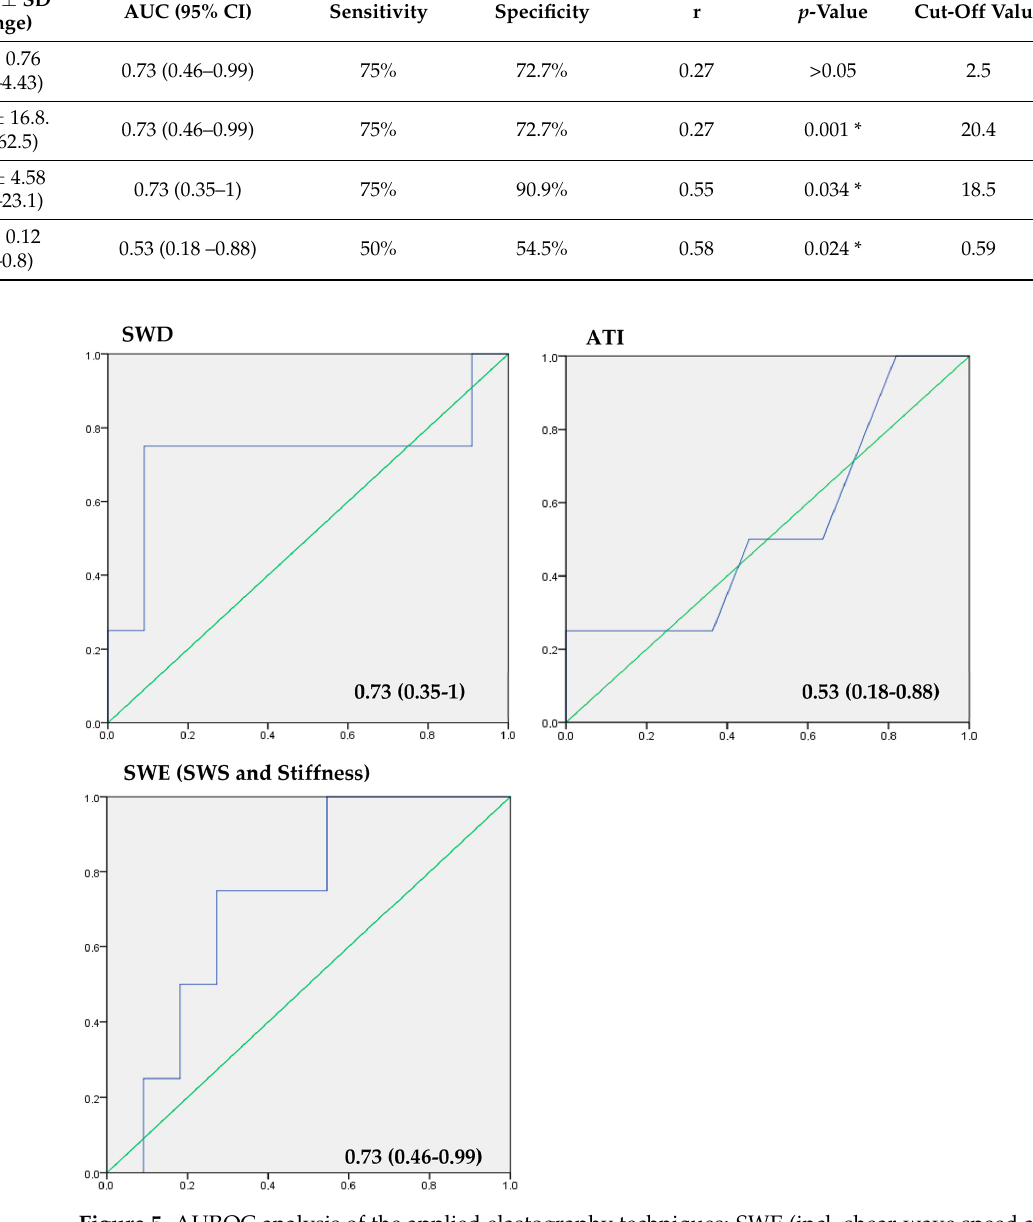
Figure 5. AUROC analysis of the applied elastography techniques: SWE (incl. shear-wave speed and stiffness measurements), SWD and ATI. The x -axis represents the reciprocal specificity and the y -axis represents sensitivity. Table 1. Overview of the quantitative analysis results of SWE, SWD and ATI and the corresponding statistical analysis results of ROC/AUROC analysis, Pearson’s coefficient and t -test application for paired samples. A p -value < 0.05 was considered statistically significant (*). Sensitivity and specific- ity rates are based on the calculated cut-off value.